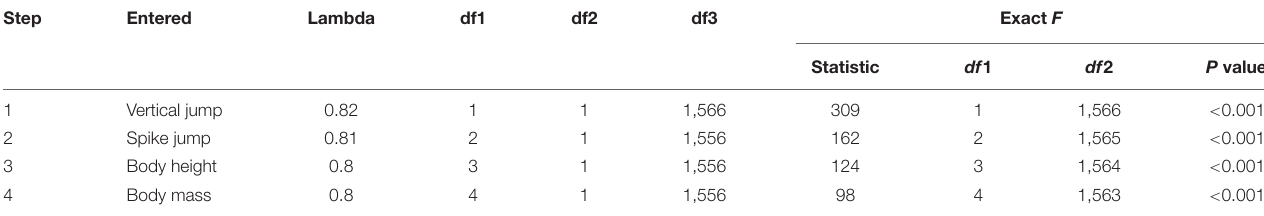
TABLE 3 | Stepwise discriminant analysis of included variables—females.